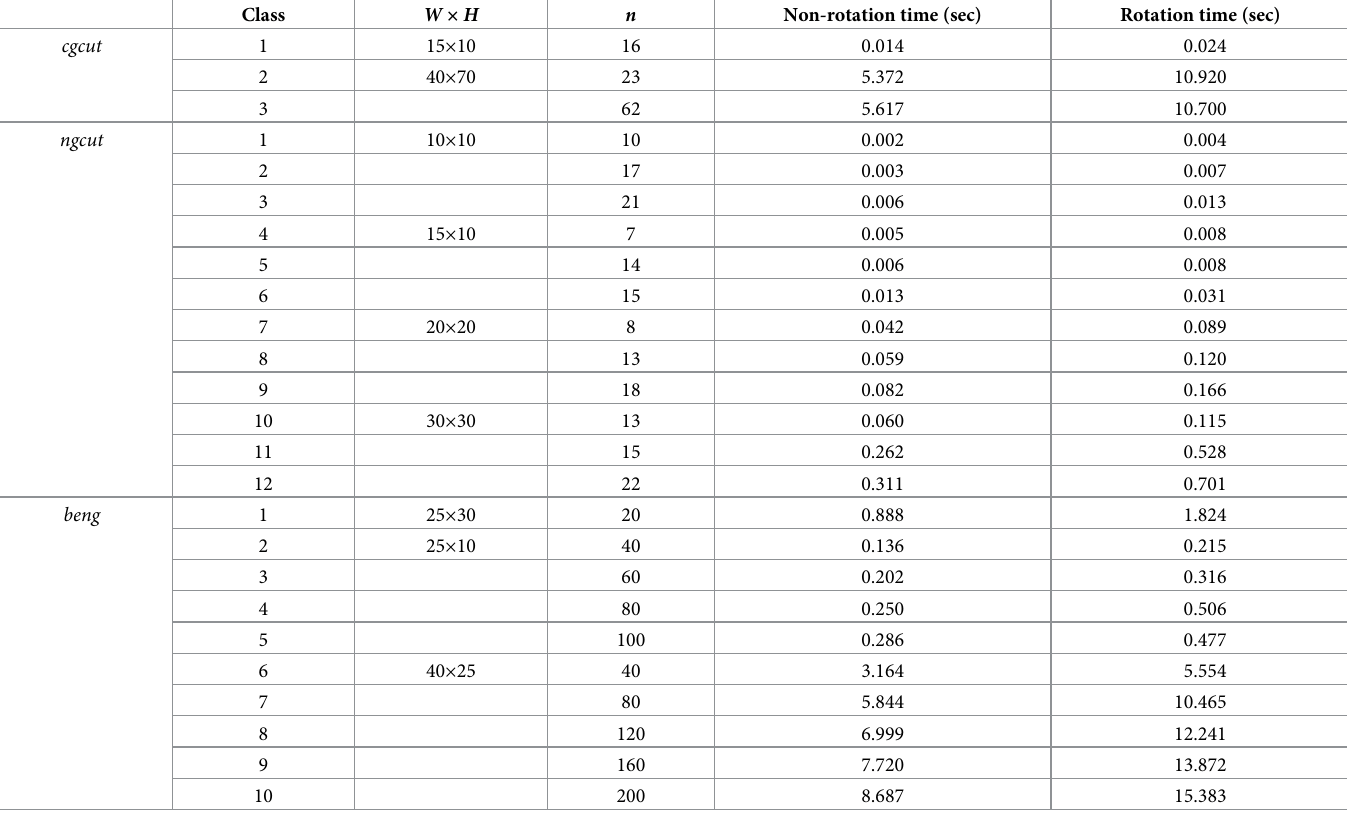
Table 4. Execution time for the Positions stage of P&C, Algorithm 1, for the cgcut , ngcut , and beng instances with and without rotations.